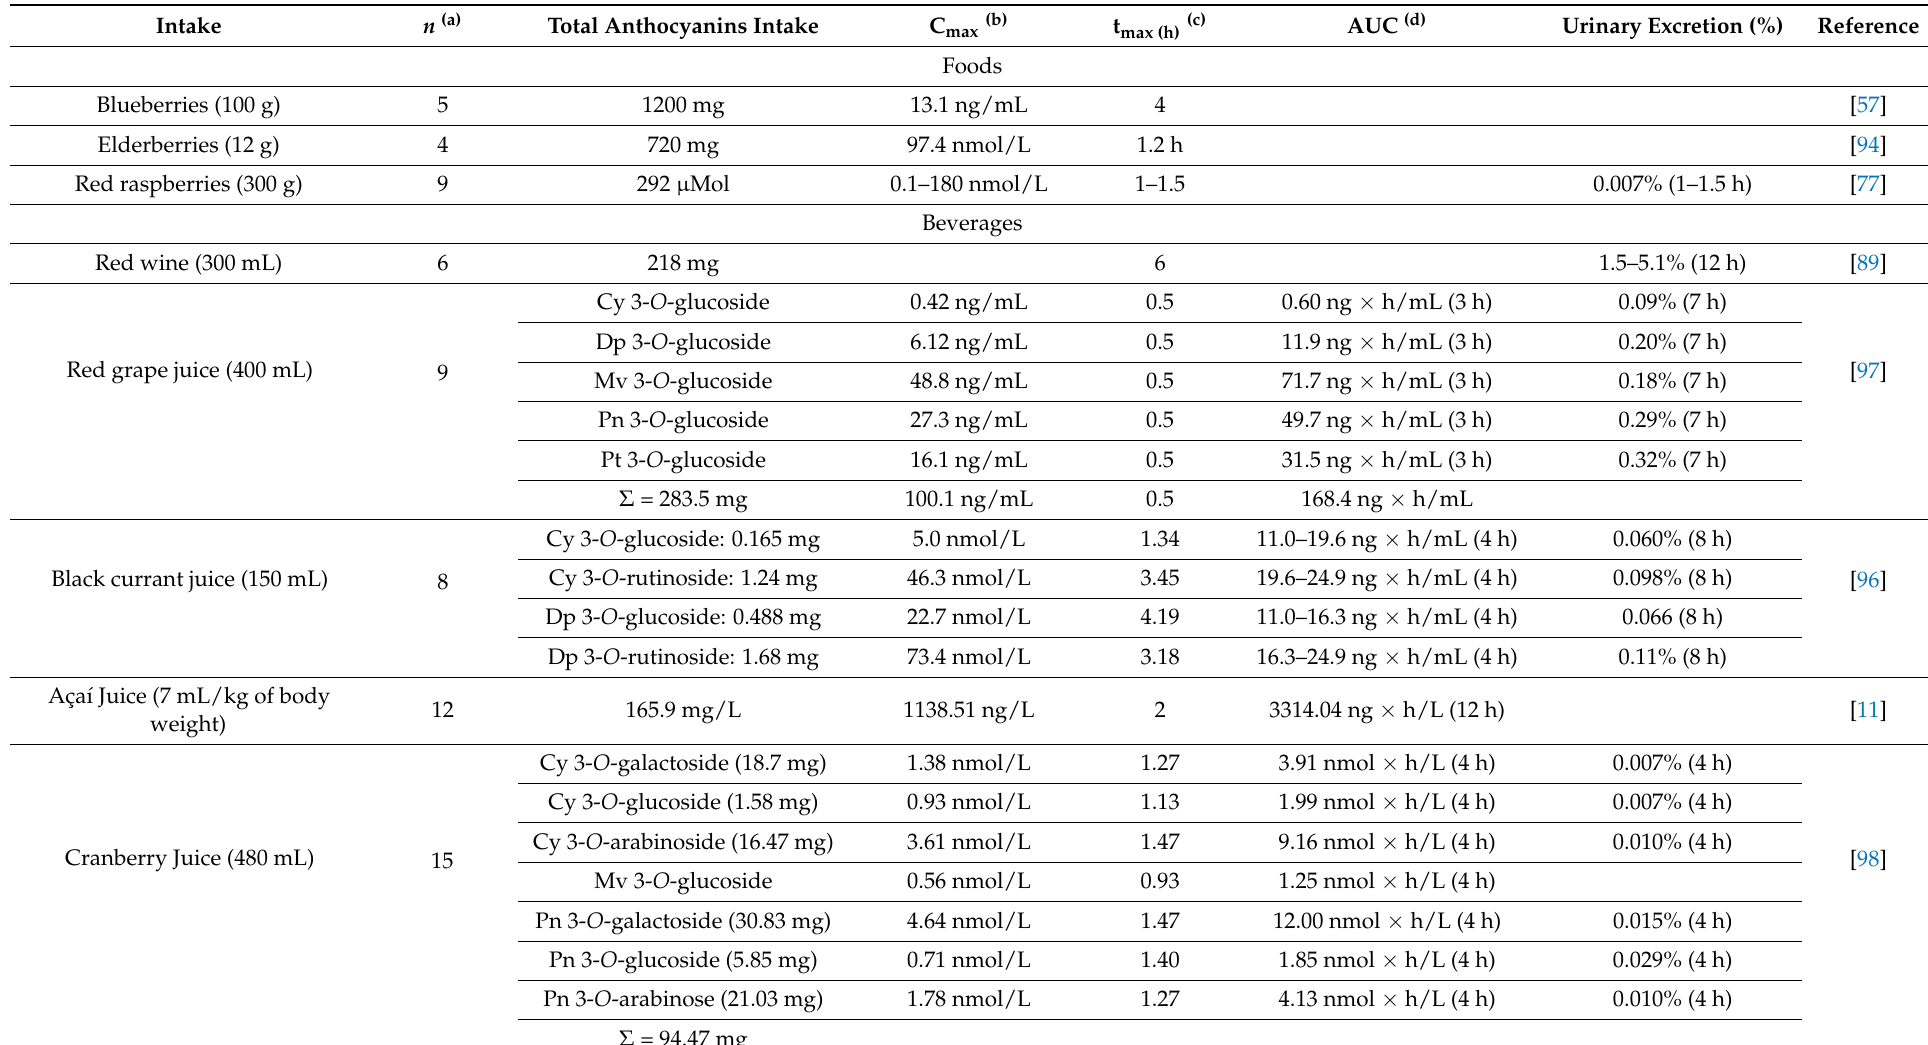
Table 2. Human studies considering the pharmacokinetic parameters of anthocyanins, after ingestion of common foods and beverages rich in this type of